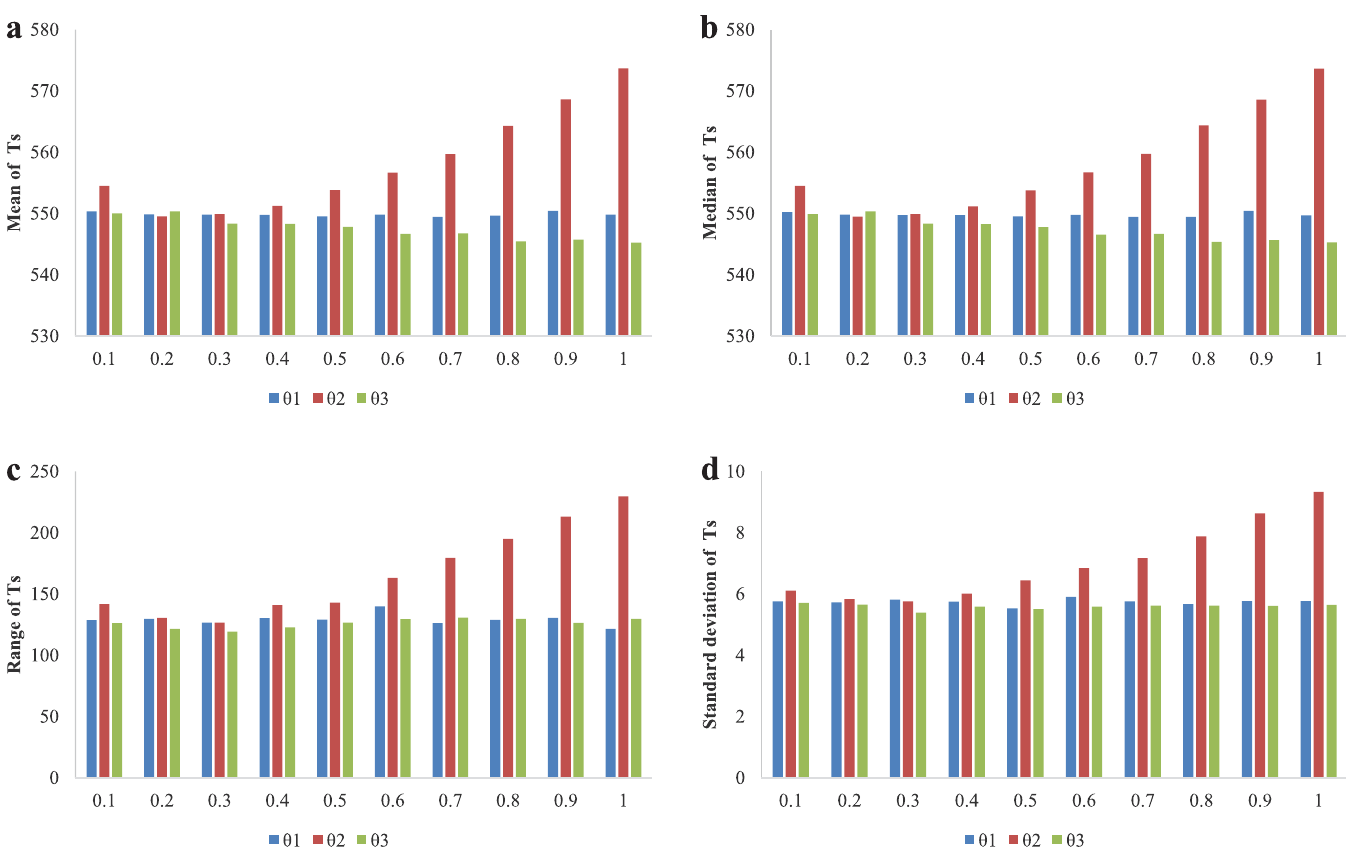
Fig 9. Results to show the mean, median, range and standard deviation of total contributions based on θ 1 , θ 2 and θ 3 . (a)-(d) The result of mean, median, range and standard deviation of Ts for θ 1 , θ 2 and θ 3 varying from 0.1 to 1 with an interval of 0.1,